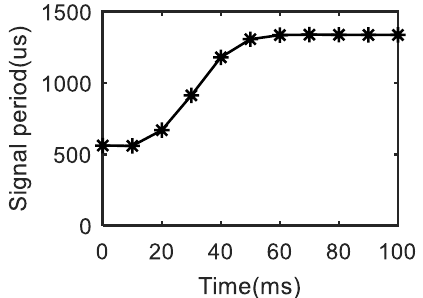
Figure 4. Signal period between the two adjacent neutral gear